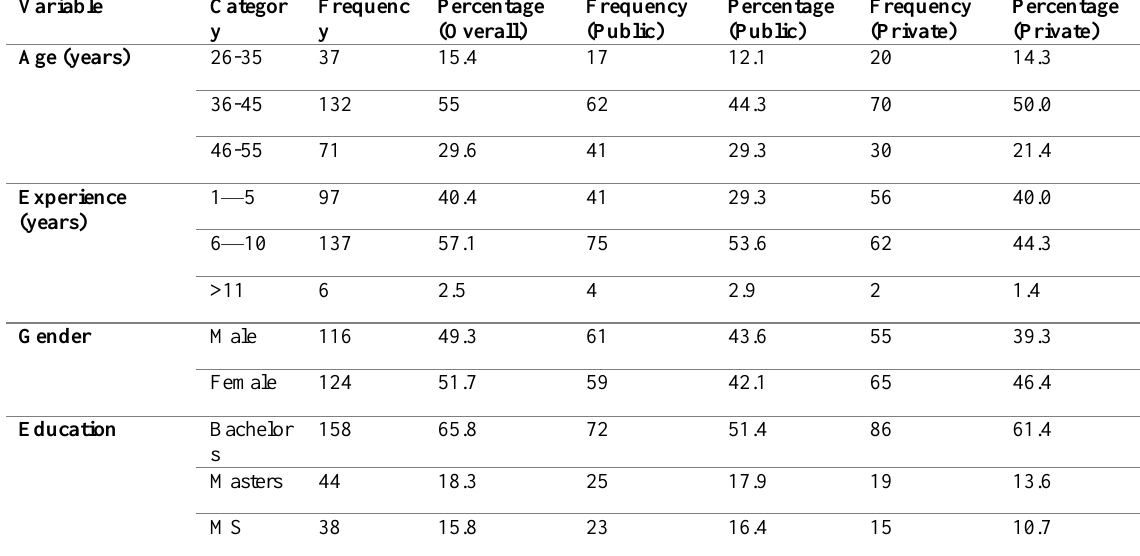
Table 1: Demographic Information of